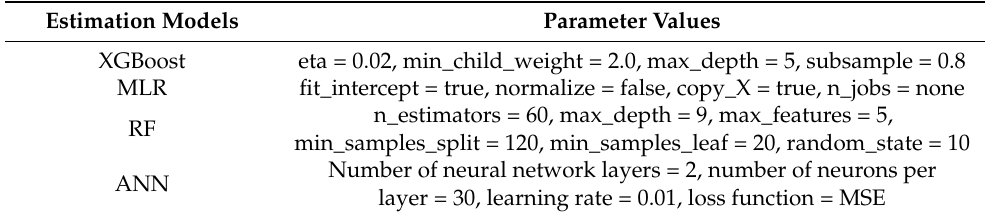
Table 5. Parameter values of different estimation models.